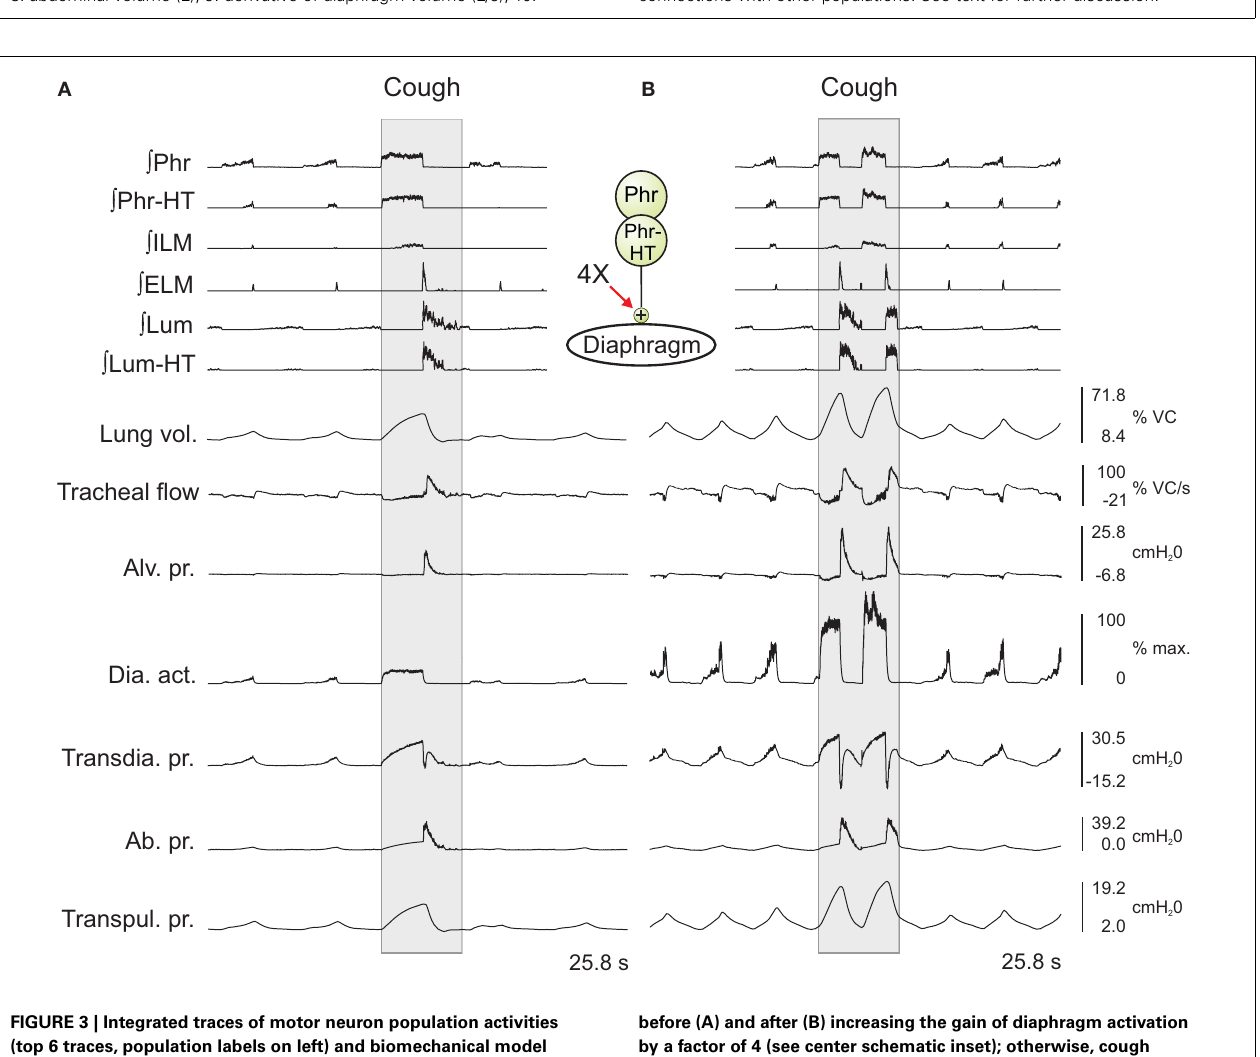
before (A) and after (B) increasing the gain of diaphragm activation by a factor of 4 (see center schematic inset); otherwise, cough stimulus parameters as in Figure 2. Scales on right are for (A,B) . See text for further details.